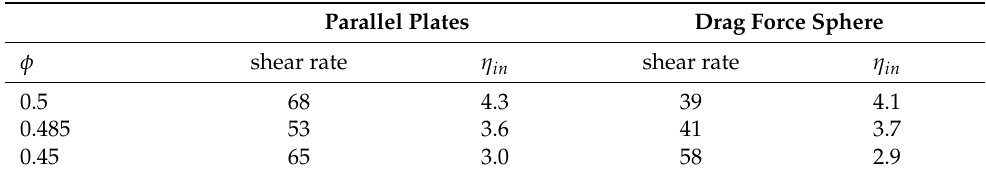
Table 4. Comparison of effective viscosity [mPas] of particle suspensions in shear flow between parallel plates vs. in drag force experiment. The viscosity of the underlying fluid was 1.2 mPas,